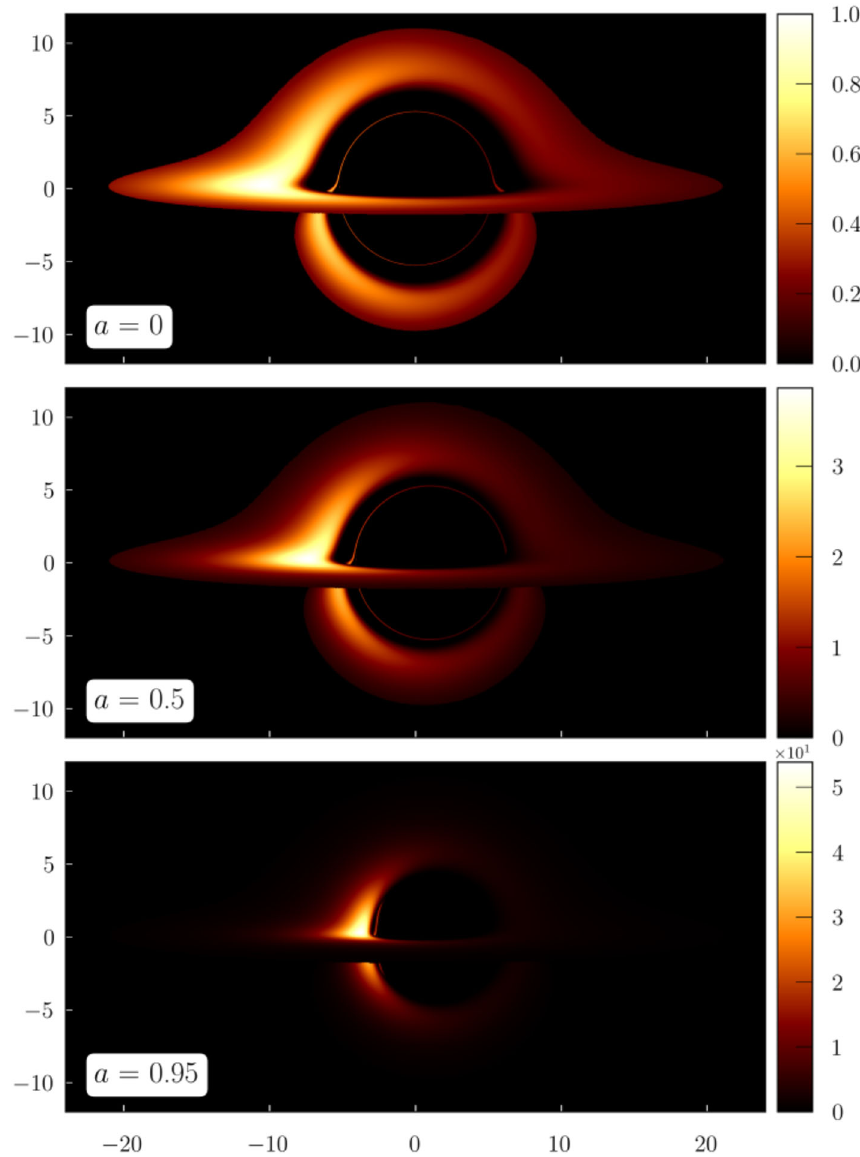
Fig. 13 Simulation of a thin accretion disk for a black hole with different spin parameter ( a = 0 , 0 . 5 , 0 . 998). The observed intensity show a bright dot at the left of the disk produced by the redshift, whose location is due to the direction of rotation of the disk. It is clear that the observed intensity increases as the spin parameter increases, being an order of magnitude higher for an extreme rotation black hole ( a = 0 . 95) compared to the non-rotating case ( a = 0) and the intermediate rotation case ( a = 0 . 5). The simulation parameters are: observer location at r 0 = 1000, θ 0 = 85 ◦ , φ = 0 ◦ and t = 0; the limits 0 0 of the disk are r in = r isco (for every case of rotation) and r out = 20. The specific angular momentum, l 0 , is 2.8 for a = 0 and a = 0 . 5, and l 0 = 1 . 8 for a = 0 . 95. The range of the image plane is x ∈ [− 24 , 24 ] and y ∈ [− 12 , 12 ] , and the resolution of the simulation is 2048 × 1024